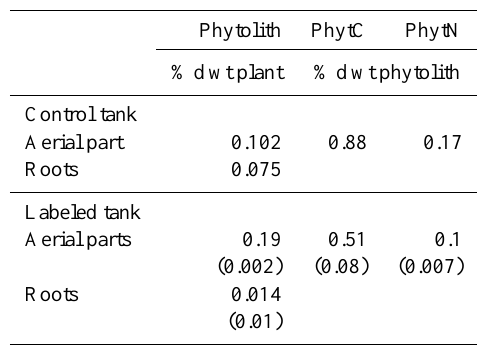
Figure 4. Natural light microscopy image of the phytolith assem- blage produced by the stems and leaves of Festuca arundinacea dominated by (e) the elongate type and (gsc) the grass short cell trapeziform type (Madella et al., 2005). Table 2. Concentration of phytoliths, phytolith occluded C (PhytC) and phytolith occluded N (PhytN) in Festuca arundinacea grown in labeled and control solutions. Numbers in italics refer to the stan- dard deviation associated with the averaged values (one value per labeled